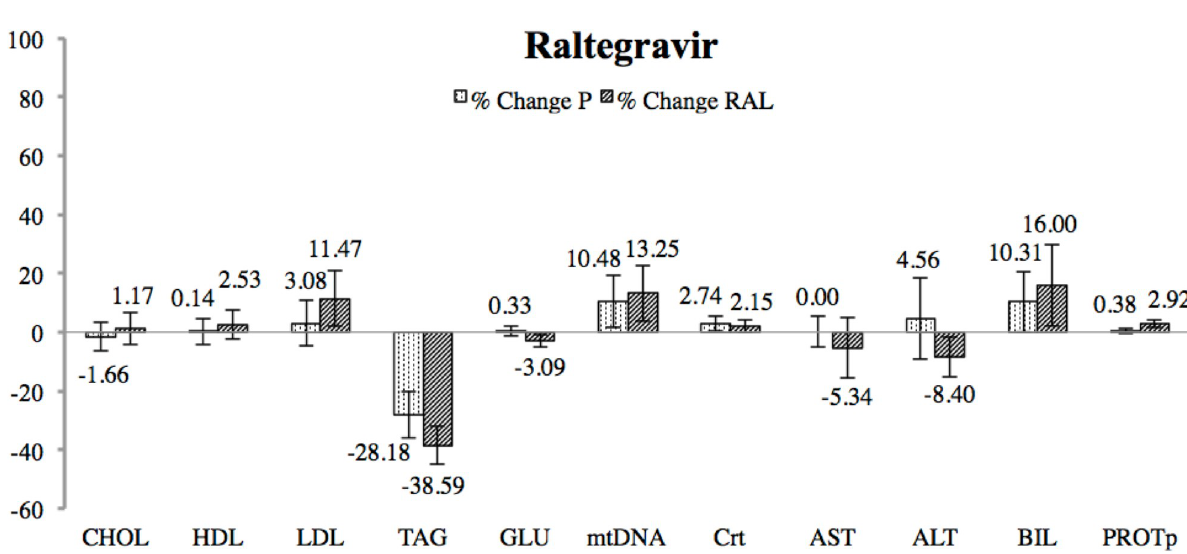
CHOL = Total cholesterol; HDL = High density lipoproteins; LDL = Low density lipoproteins; TAG = Triglycerides; GLU = Glucose; mtDNA = Mitochondrial DNA; Crt = Creatinine; AST = Aspartate aminotransferase; ALT = Alanine transferase; BIL = Bilirubin; PROTp = Total plasma proteins; PRE = Values before starting placebo/ RAL; POST = Values after starting placebo/RAL.